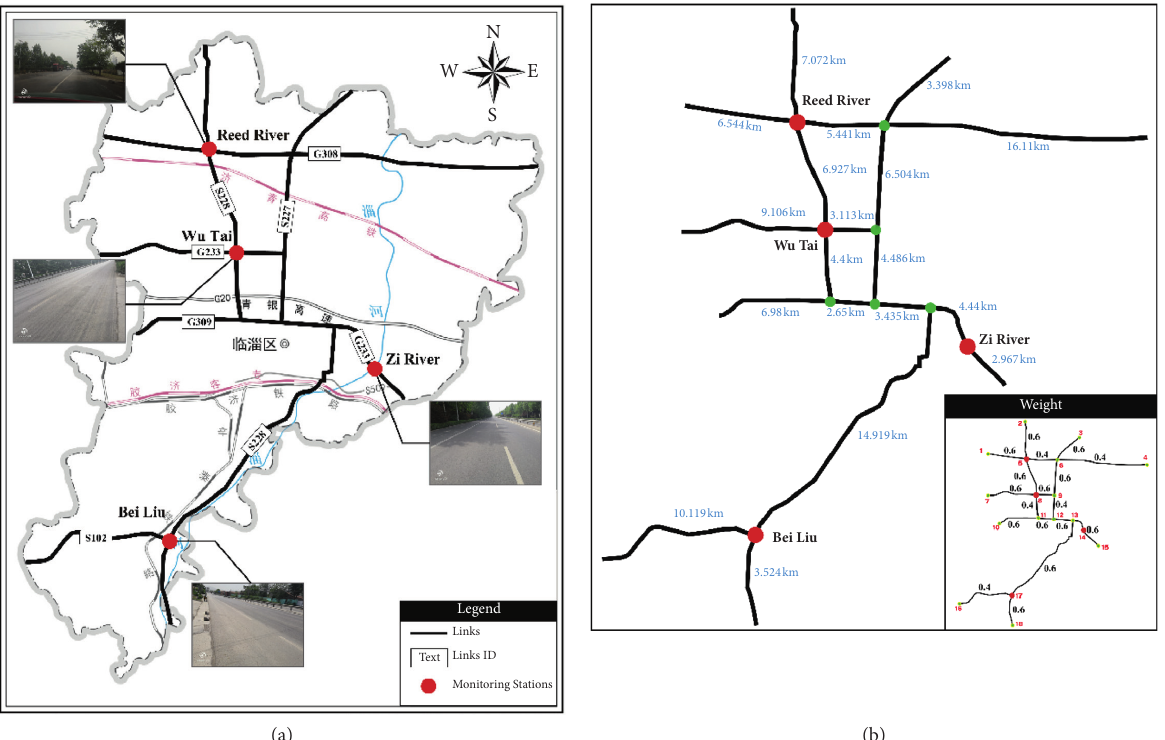
Figure 5: Selected road network in Linzi District. (a) Station location map in Linzi District. (b) Network diagram of links with the division of weights